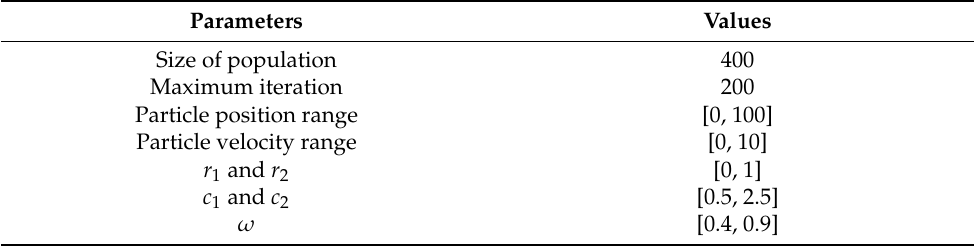
Table 3. Parameters of